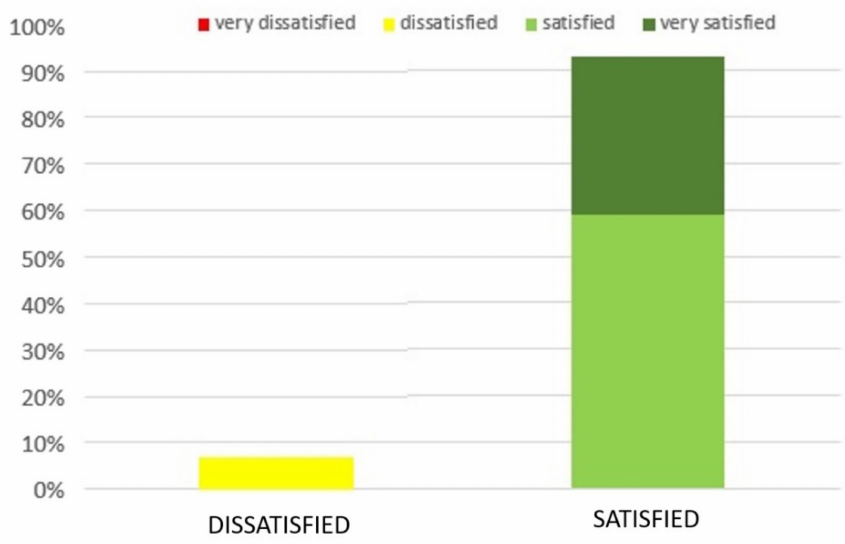
Figure 2. Patients’ satisfaction after treatment with IRT.